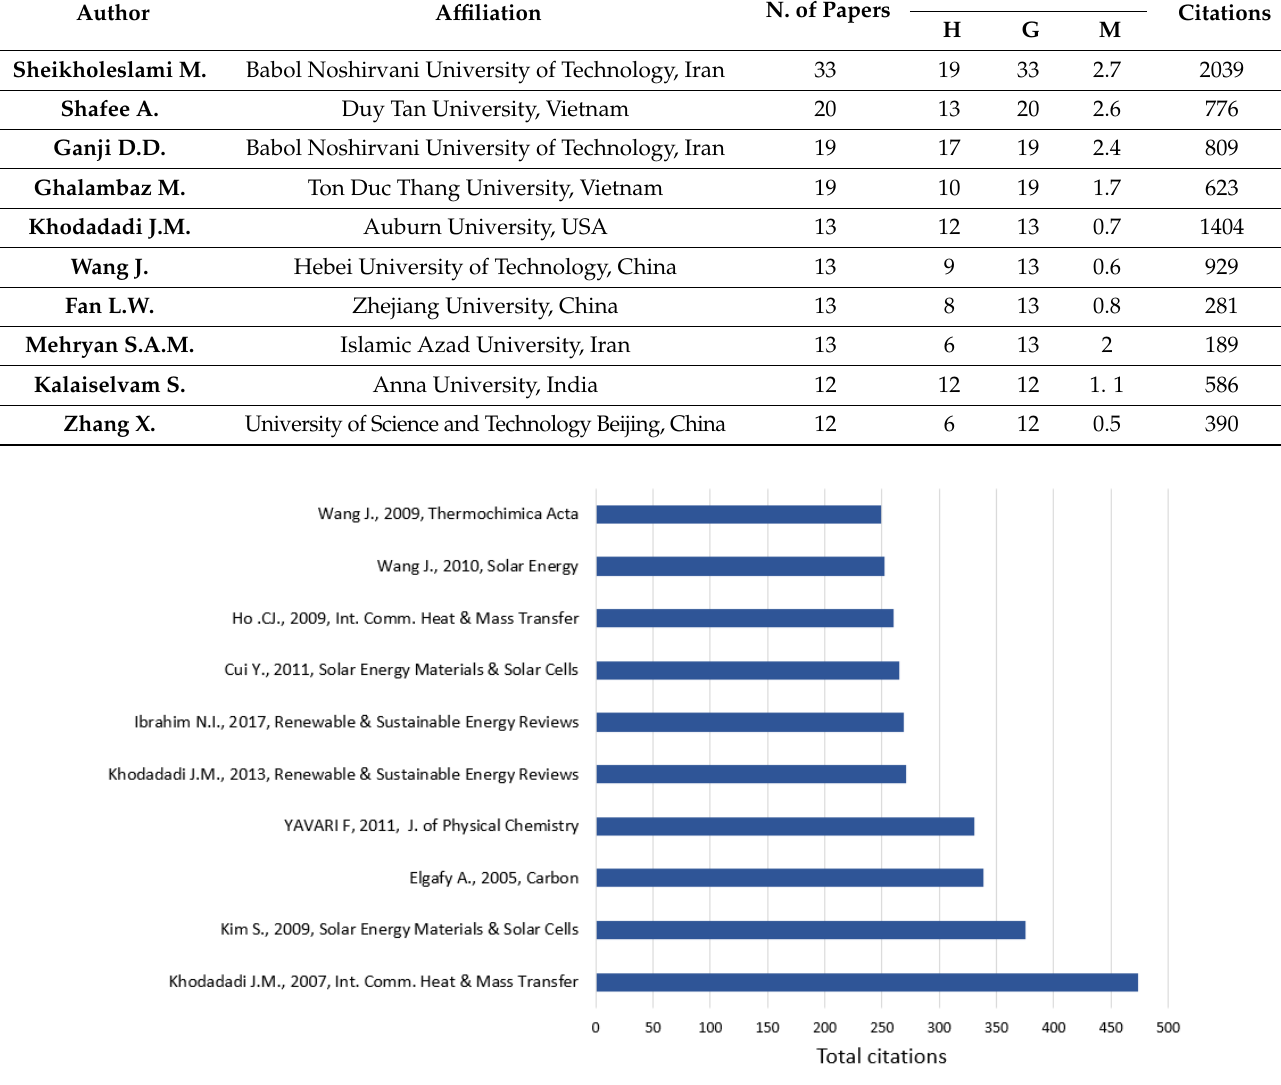
Figure 11. Most cited countries for research in TES using NePCM.